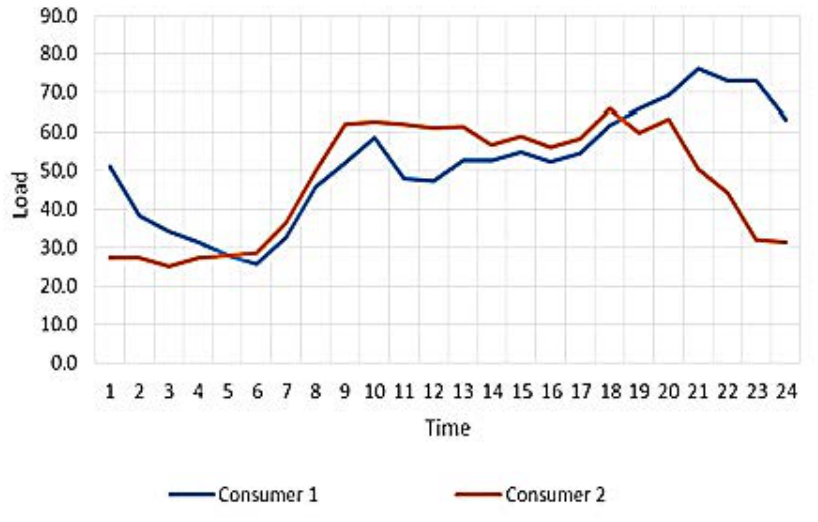
Figure 3. The loads of Consumers 1 and